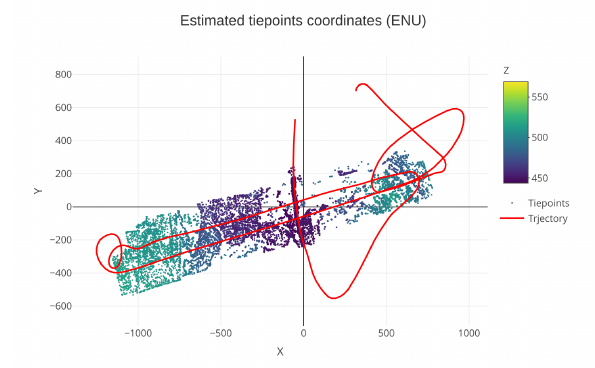
Figure 6. Map of the estimated tie-points positions, in a local Euclidean reference frame. The estimated trajectory is highlighted in red.